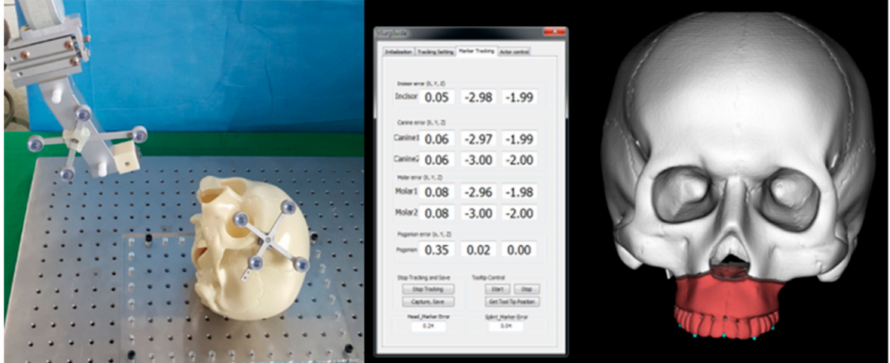
Figure 4. Tracking the three-dimensional movements of the end-e ff ector and visualization of the estimated maxillary position on the